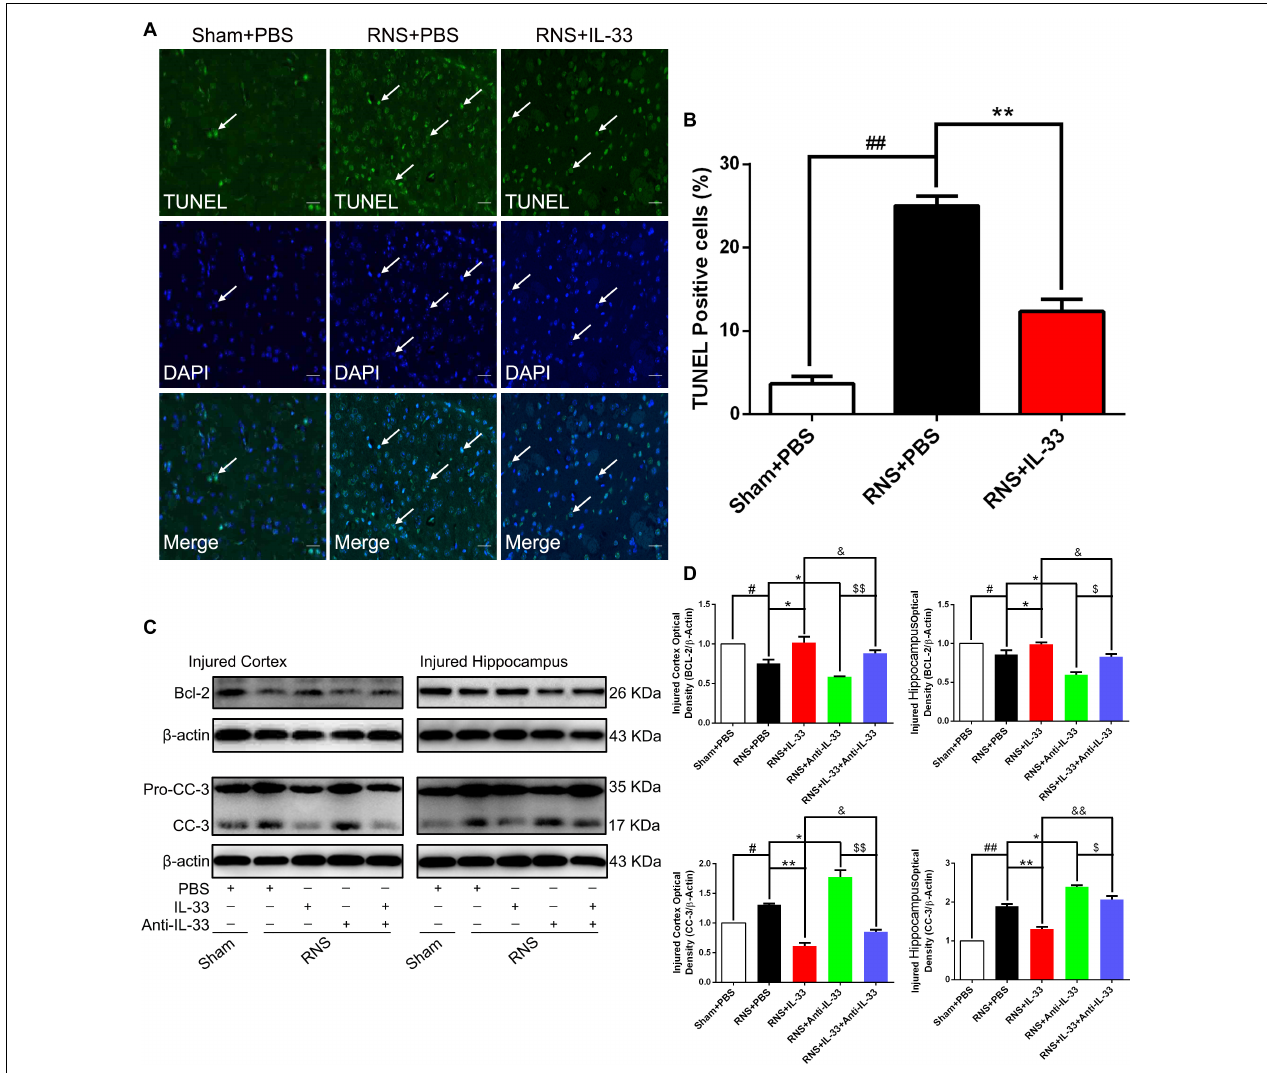
FIGURE 5 | IL-33 inhibited cell apoptosis through reversing RNS-induced Bcl-2 decrease and CC-3 increase. (A) Representative immunofluorescence photomicrograph showed a significant increase in the number of TUNEL-positive cells. However, the administration of IL-33 contributed to a significant decrease in TUNEL-positive cells at 72 s post-RNS. (B) Semi-quantitative analysis of TUNEL-positive cells relative to the total number of cells. (C) Administration of IL-33 alone reversed RNS-induced down-regulation of Bcl-2 expression and up-regulation of CC-3 expression, while Anti-IL-33 alone treatment further down-regulated the expression level of Bcl-2 and up-regulated the expression level of CC-3. However, the combined treatment of IL-33 and Anti-IL-33 reversed the effect of IL-33 alone or Anti-IL-33 on the expression level of Bcl-2 and CC-3, suggesting that IL-33 inhibits RNS-induced apoptosis at 72 h post-RNS. IL-33 pretreatment and Anti-IL-33 treatment reversed IL-33’s effect on the two types of apoptosis-related proteins in both cortex and hippocampus tissues after RNS. (D) Optical densities of the protein bands were quantitatively analyzed, and normalized with loading control β -actin. The data were expressed as means ± SEM ( n = 6). ## P < 0.01 vs. Sham + PBS group, # P < 0.05 vs. Sham + PBS group. ** P < 0.01 vs. RNS + PBS group, * P < 0.05 vs. RNS + PBS group. && P < 0.01 vs. RNS + IL-33 group, & P < 0.05 vs. RNS + IL-33 group. $$ P < 0.01 vs. RNS + IL-33 group, $ P < 0.05 vs. RNS + Anti-IL-33 group. Experiments are representative of three independent